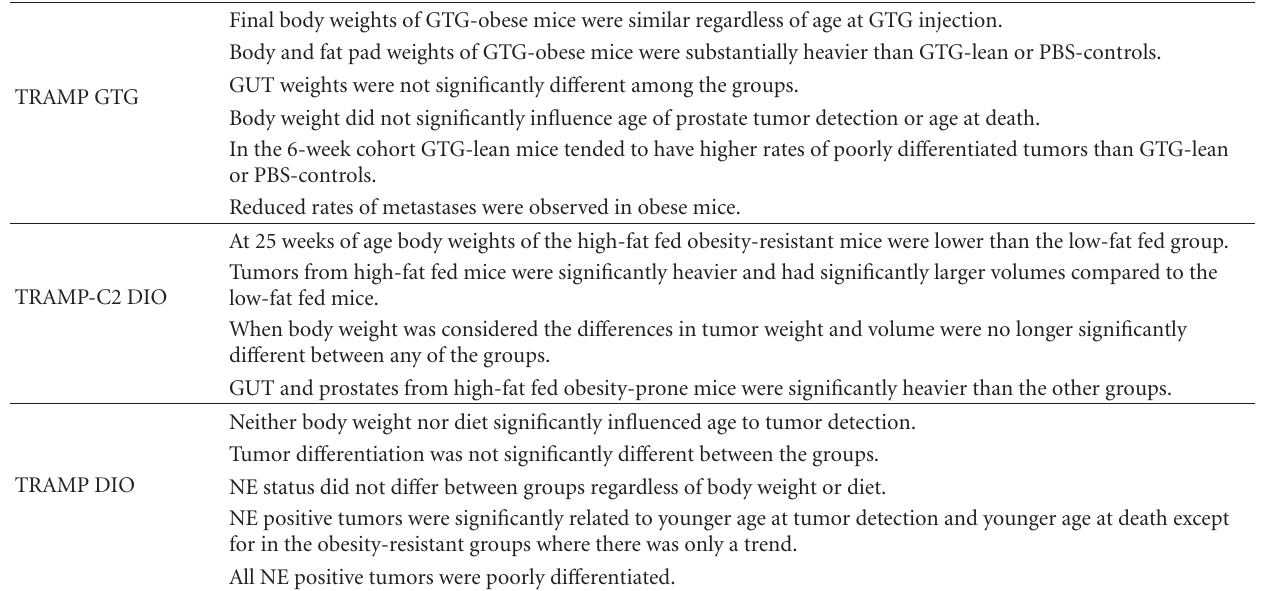
Table 4: Overview of findings from the three